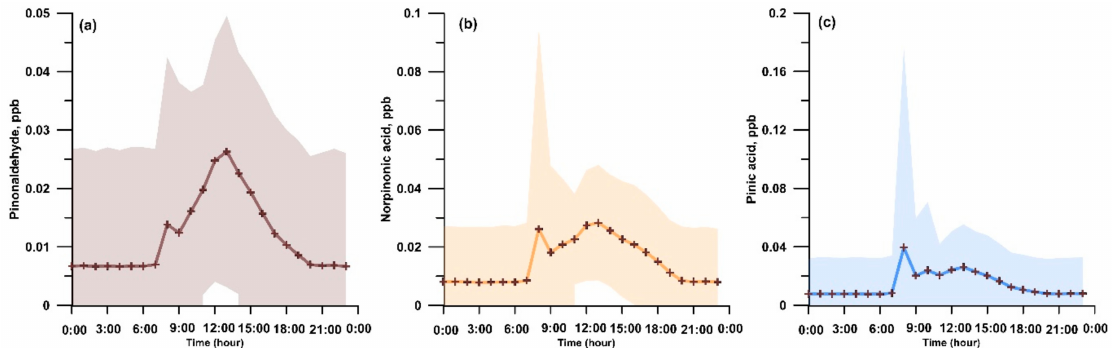
Figure 3. Diurnal profile of ( a ) pinonaldehyde, ( b ) norpinonic, and ( c ) pinic acid in gas phase measured in the subtropical forest. The shaded area is the variability of measurement given by 1 standard deviation. Time series profiles are given in the